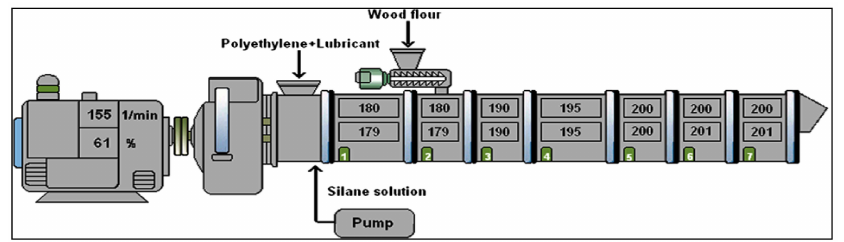
Figure 2. Extruder machine for WPC